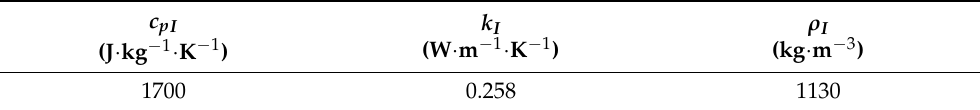
Table 4. Thermoplastic polyurethane properties.